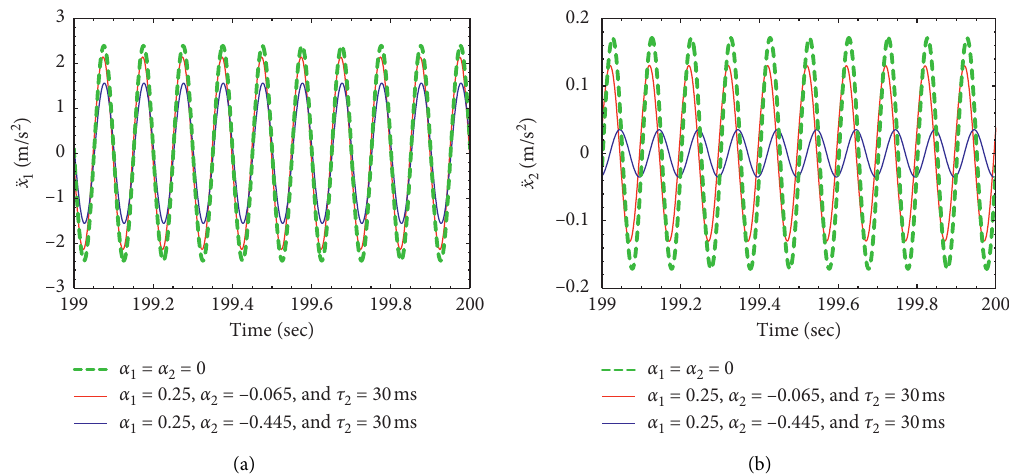
Figure 11: Numerical simulations of the time histories of system responses for Ω � 10Hz and f � 1N: (a) absorber and (b) primary system.